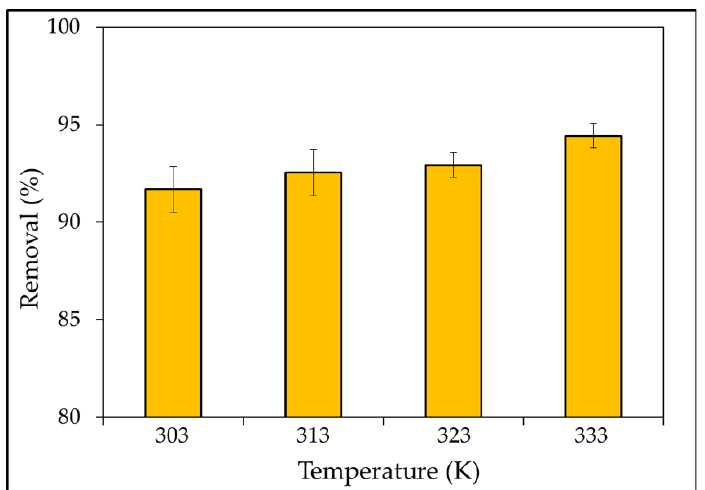
Figure 9. Effect of temperatures function of percentage elimination of MBD (temperatures (303 – 333 K); adsorbent dose (0.1 g); MB dye initial concentration 5 mg L − 1 ; pH value 6; 180 rpm; and initial volume: 50 mL).